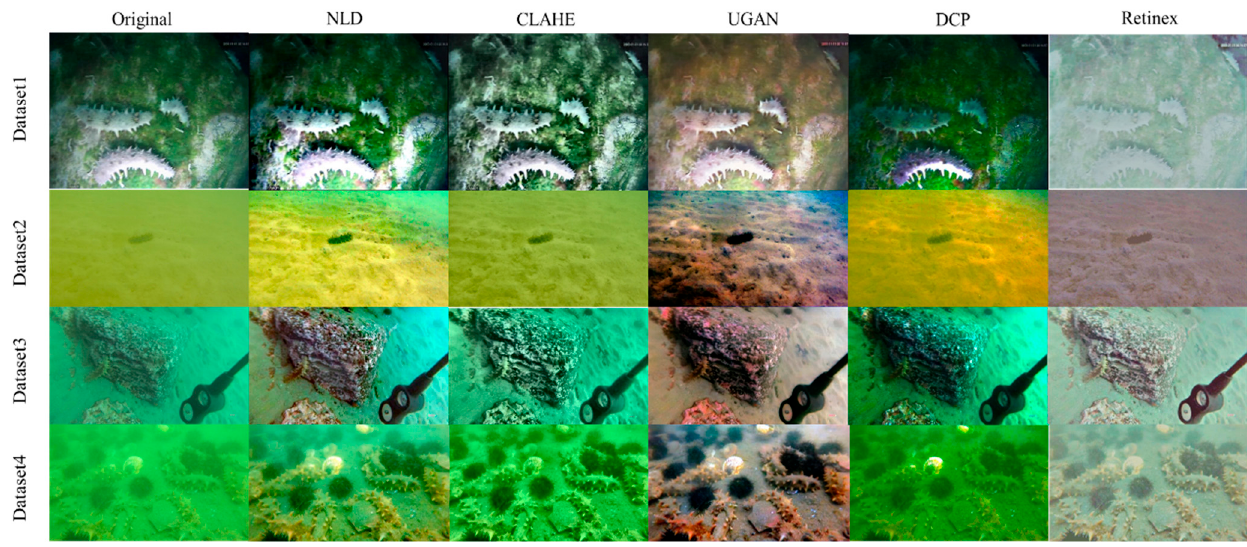
Figure 7. Examples of underwater image datasets and image enhancement.